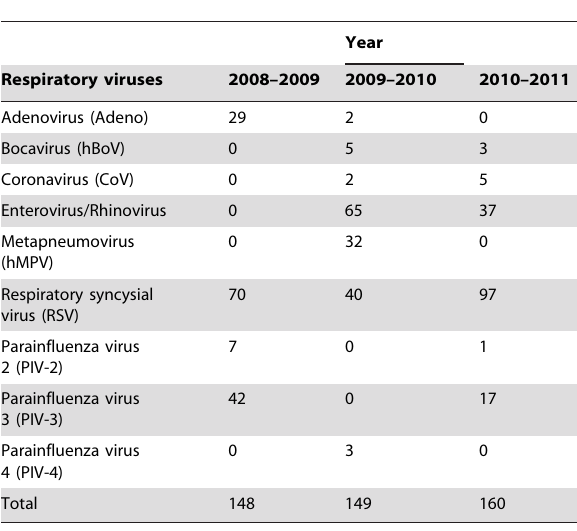
Table 2. Number of respiratory viruses detected by Luminex circulating in Tunisia in 2008–2009, 2009–2010 and 2010– 2011